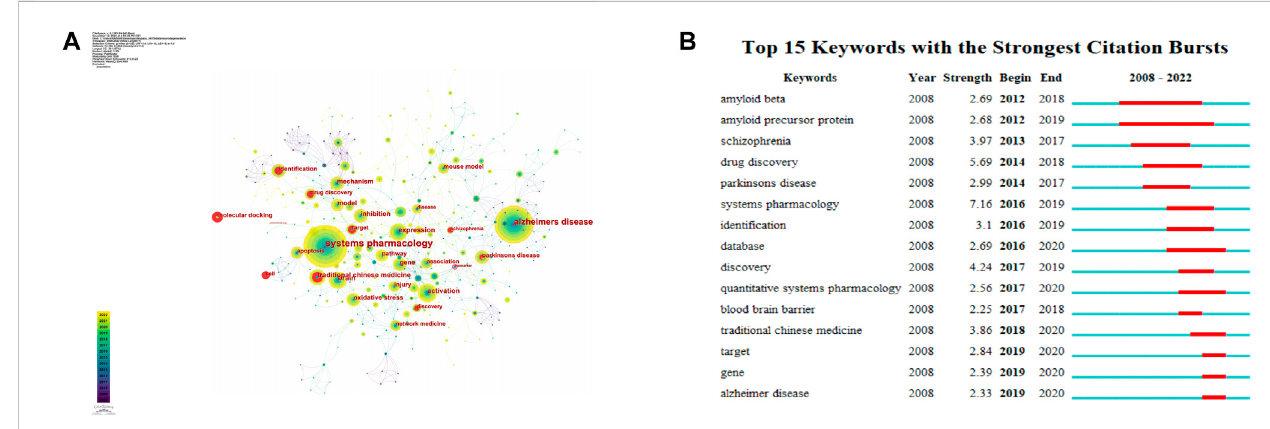
FIGURE 8 Analysis of keywords. (A) CiteSpace visualization of keywords. (B) Top 15 keywords with the most strongest bursts.